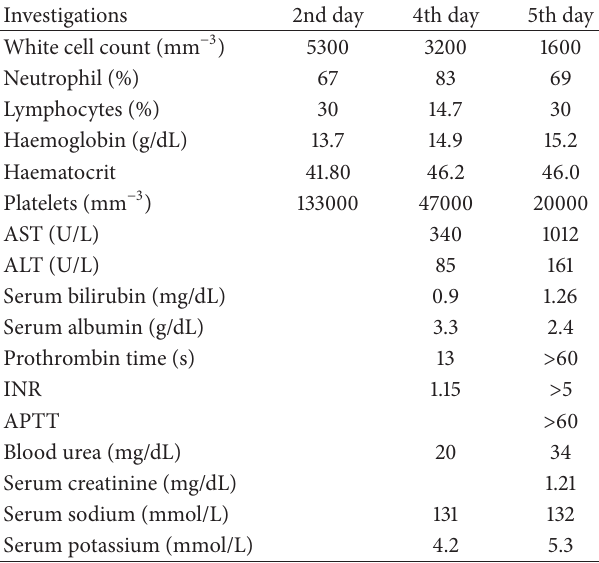
Table 1: Investigation results during the illness.